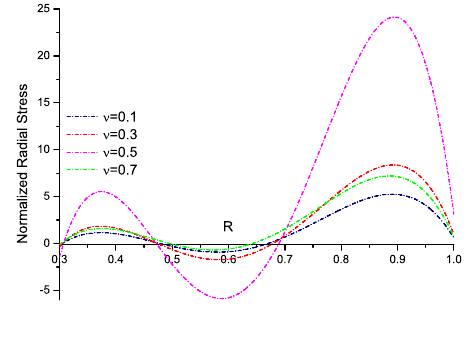
Figure 9: Variation of normalized radial stress with Poisson’s ratio